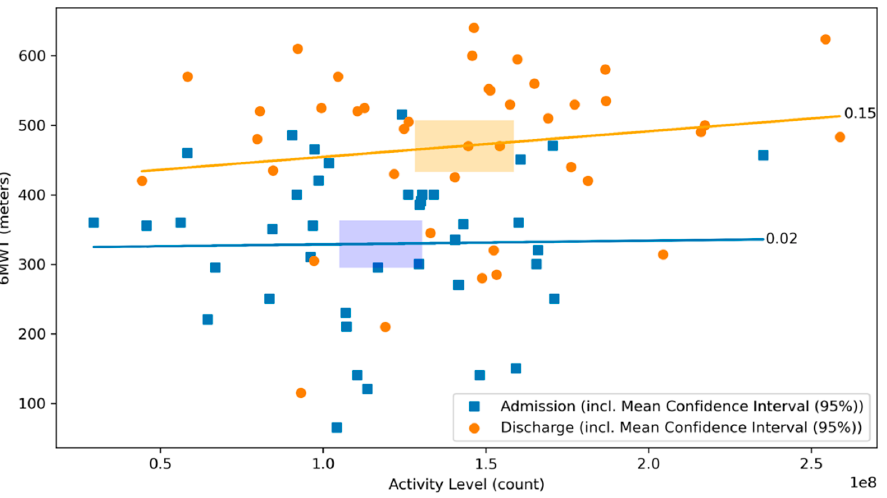
Figure 5. Scatterplot of 6MWT and activity level at admission and discharge with respective correlation coefficients. The relationship between the 6MWT and the activity level at admission (blue) and discharge (orange) of the CR stay are illustrated. The graph visualizes their respective correlation coefficients. Blue dots represent patients at admission, whereas orange dots represent patients at discharge. The lines depict the correlation coefficient between the 6MWT and the activity level at admission in blue and at discharge in orange. The rectangles represent the mean confidence intervals of the respective means (r = 0.02, p = 0.90 and r = 0.15, p = 0.35, respectively).